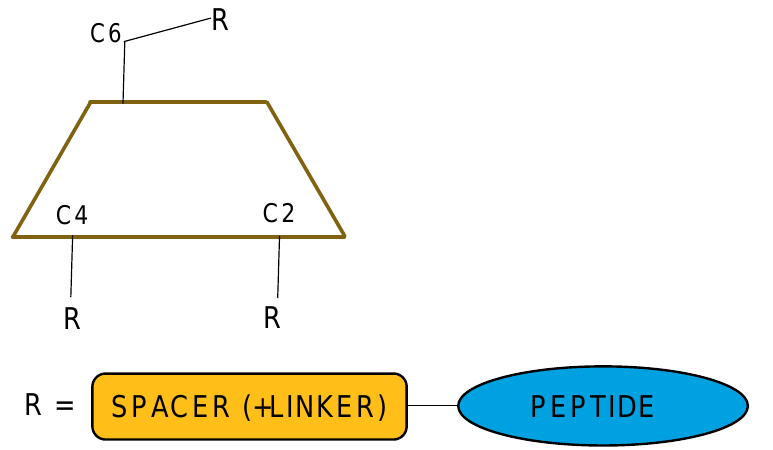
Figure 2. Cyclodextrin conjugate: possible structure.